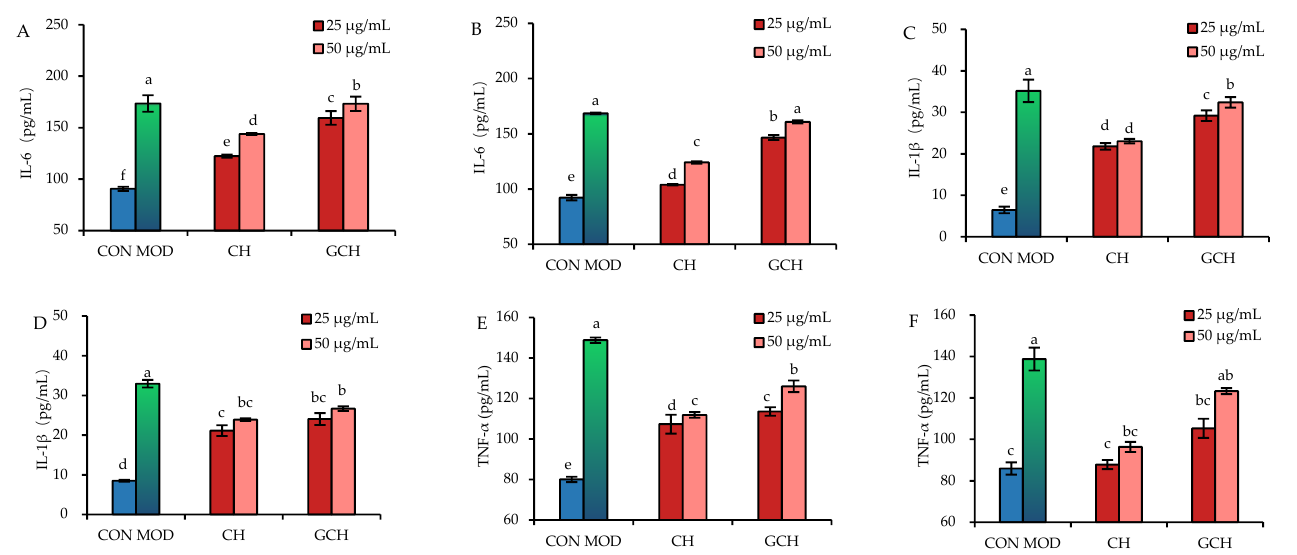
Figure 4. Secretion of IL-6 ( A , B ), IL-1 β ( C , D ), and TNF- α ( E , F ) in IEC-6 cells treated with casein hydrolysate (CH) and glycated casein hydrolysate (GCH) for 12 h ( A , C , E ) and 24 h ( B , D , F ), respectively, followed by 10 μg/mL LPS treatment of 24 h. The abbreviation “CON” and “MOD” denotes the respective control and model cells. The one-way ANOVA of the mean values with different lowercase letters above the columns indicates a significant difference ( p < 0.05).